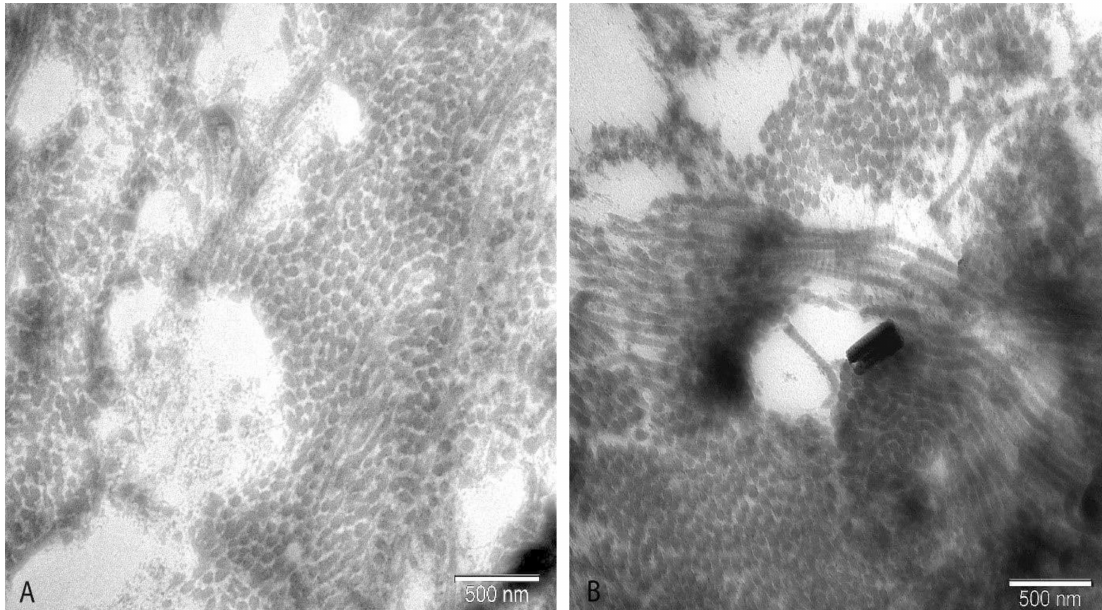
Figure 2. ( A ) Vertebral collagen fibrils from a non-deformed seabream. ( B ) Vertebral collagen fibrils from a seabream with scoliosis. In the second image, the fibrils have a significantly smaller diameter. The Kolmogorov-Smirnov test was used for normality checking of the collagen fibrils’ diameter. Table 1. Scoliotic and non-deformed seabreams’ vertebral collagen fibril